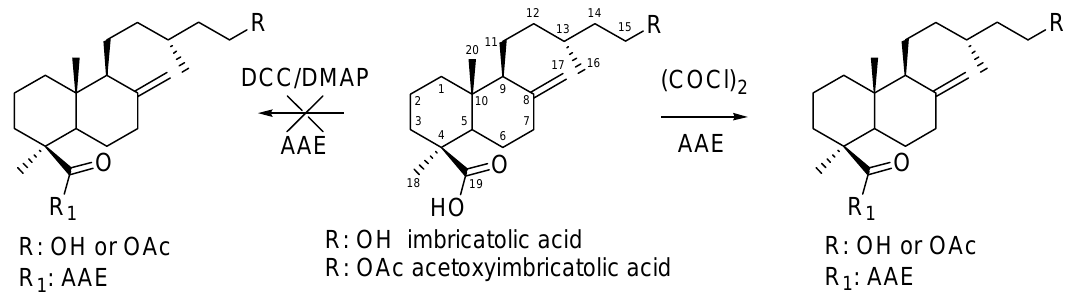
Reagents and conditions : (a) appropriate amino acid ester (AAE), N , N ′ -dicyclohexylcarbodiimide (DCC), dimethylaminopyridine (DMAP), dichloromethane (CH CH Cl , 2 2